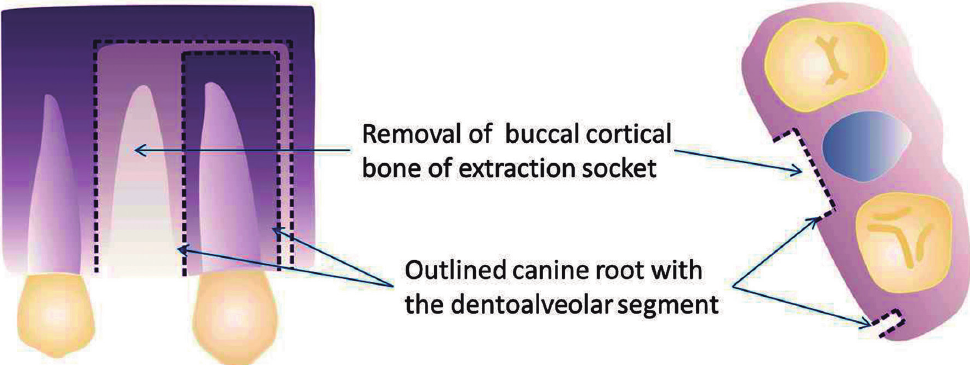
Figure 4- Surgical techniques for dentoalveolar distraction